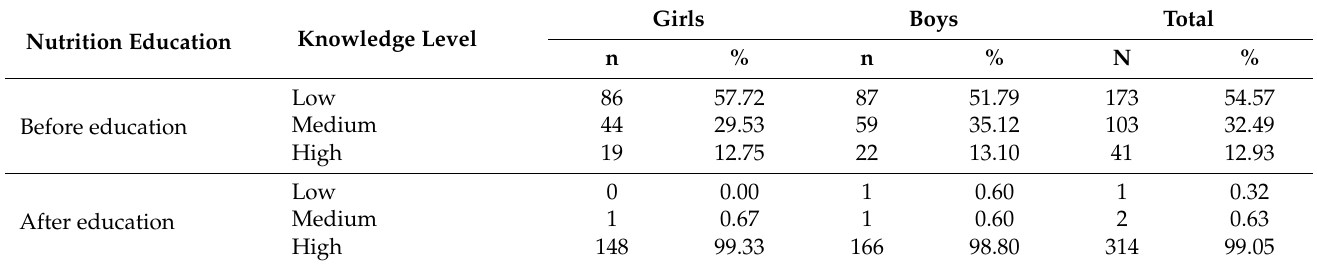
Table 3. Knowledge level of surveyed students before and after the educational programme.